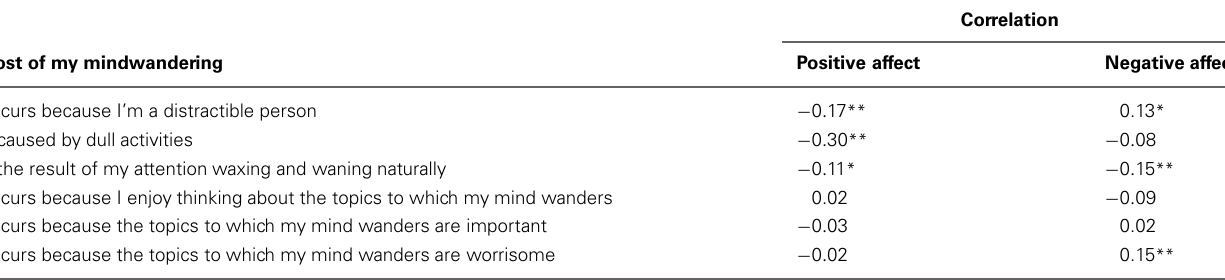
Table 2 | Prediction of mood subsequent to mindwandering, by Lay